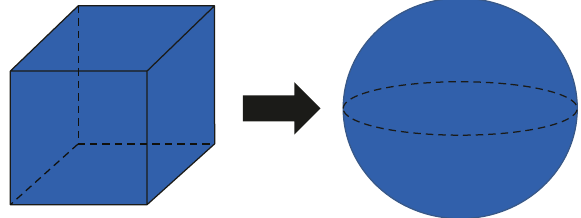
Figure 8: Schematic for contact between matrix and volume